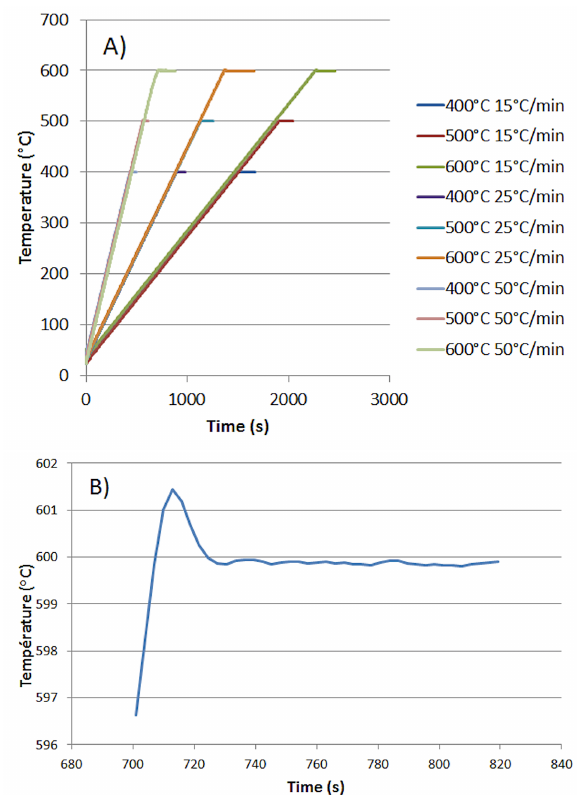
Figure 3. Temperature ramps for 400, 500, 600 ◦ C set temperature and 15, 25, 50 ◦ C/min ramp (b) overshoot example at 600 ◦ C and 50 ◦ C/min ramp